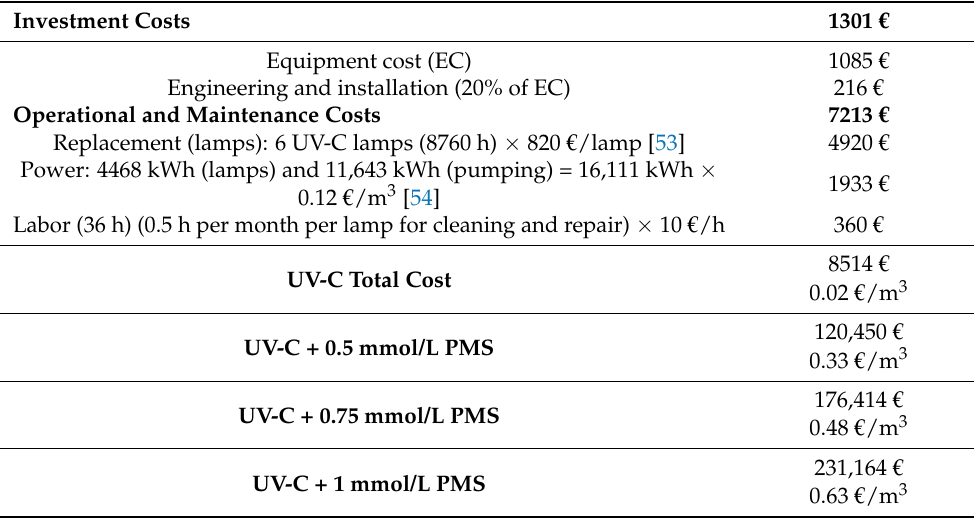
Table 1. Breakdown of the estimated UV-C and PMS/UV-C annual costs for UWW treatment in a continuous flow reactor. Investment Costs 1301 € Equipment cost (EC) 1085 € Engineering and installation (20% of